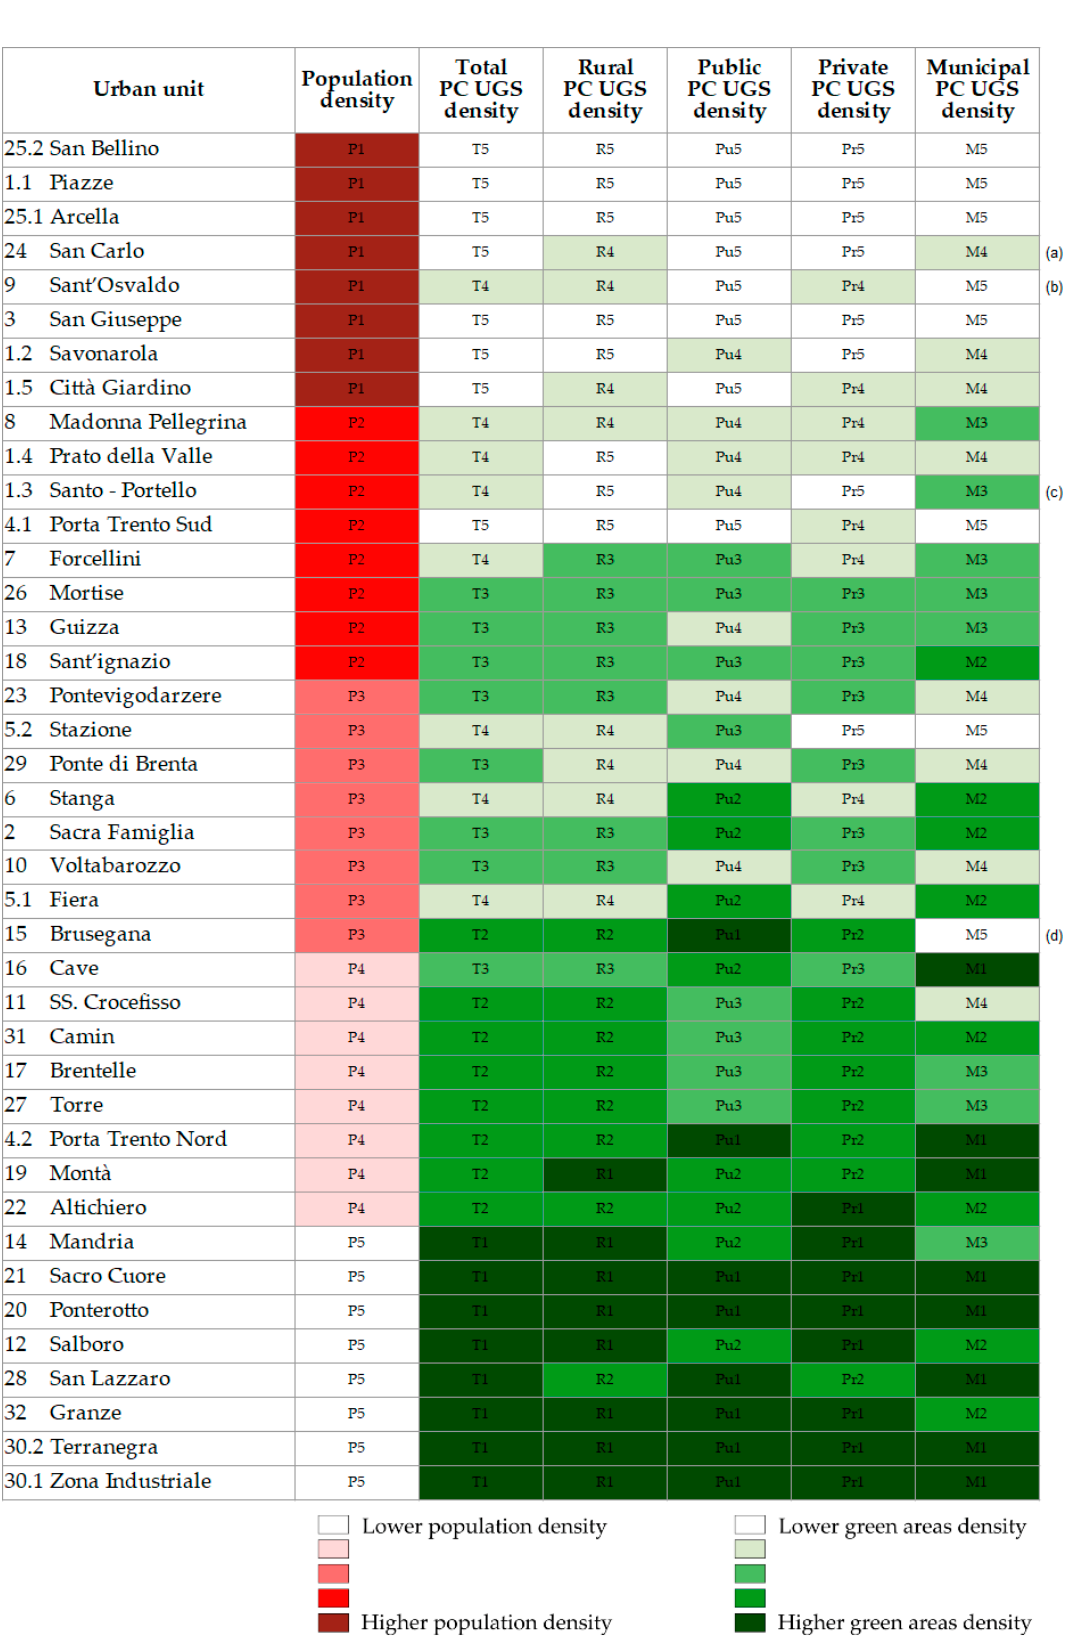
Figure 14. Density classes for population and urban green space categories in the urban units of Padua, based on per capita (PC) values displayed in Table 11 and subdivided into quintiles. Units a–d are quoted as samples for outlining UGS management strategies in Section